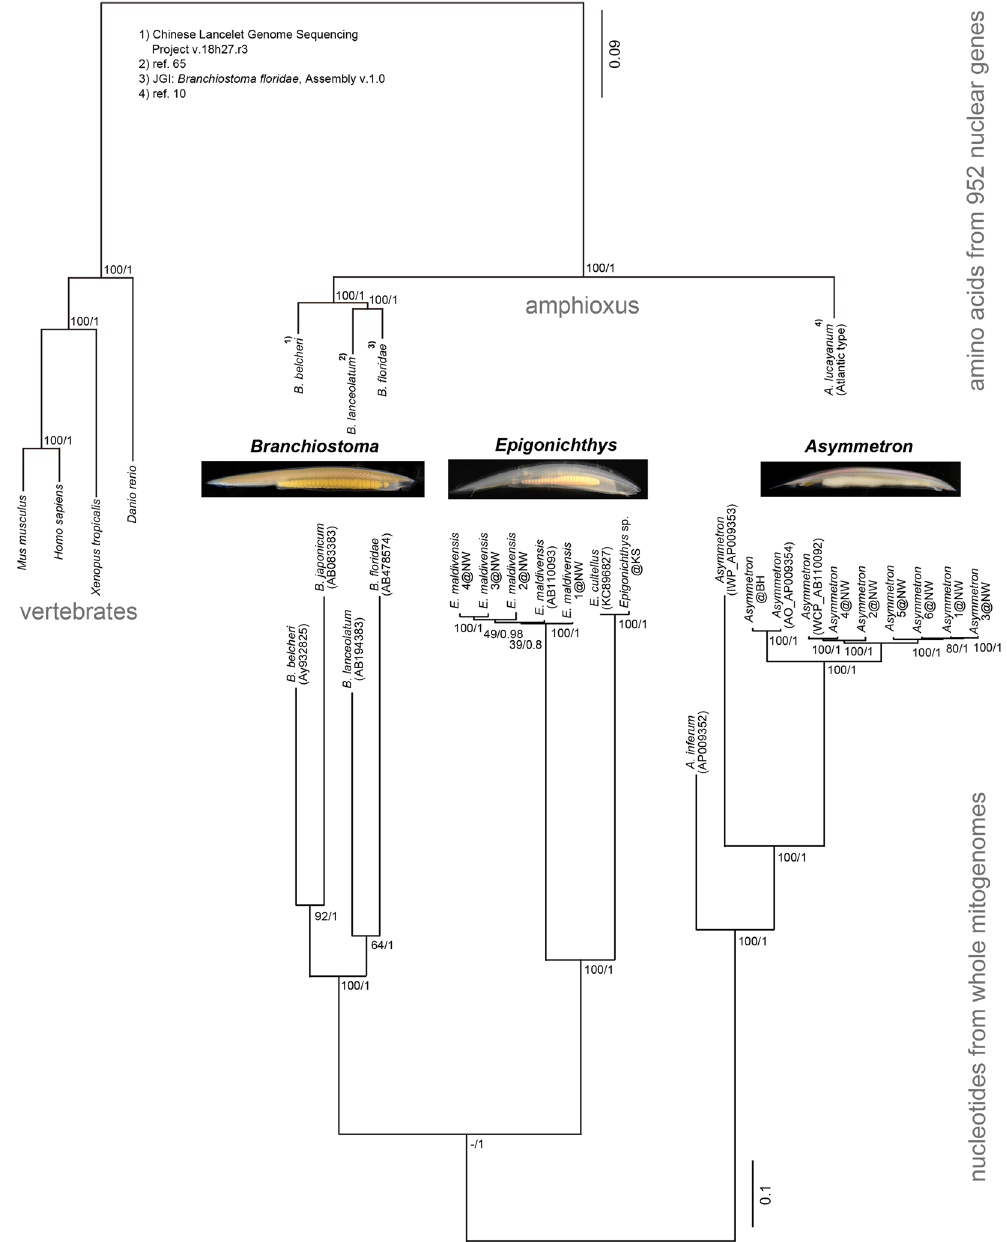
Figure 1. Phylogenetic trees of three extant amphioxus genera based on mitogenomes and nuclear transcriptomes. Bayesian and maximum likelihood methods gave the same topology for both trees based on amino acid sequences of nuclear transcriptomes (top) and on nucleotides of whole mitogenomes (bottom). Values at nodes are bootstrap values (left side) and posterior probabilities (right side). The top tree includes four vertebrate species and shows the monophyly of B. lanceolatum and B. floridae as shown in the bottom tree. The Asymmetron sequence in the top tree is derived from Atlantic type 4 . Numerals and initials in Epigonichthys and Asymmetron clades denote specimen numbers and types 4 /locations. IWP, Indo-West Pacific type; AO, Atlantic type; WCP, West-Central Pacific type; BH, Bahamas; NW, Nanwan Bay; KS,